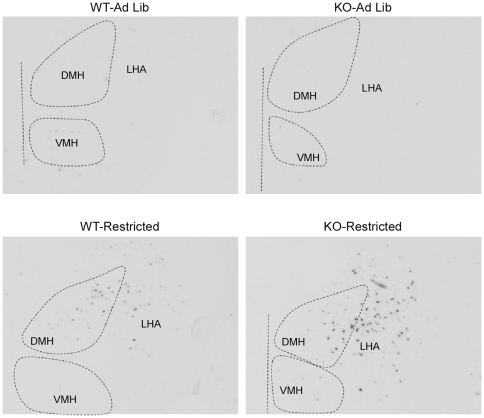
Representative photomicrographs of hypothalamic DMH/LHA c-fos expression at ZT4.